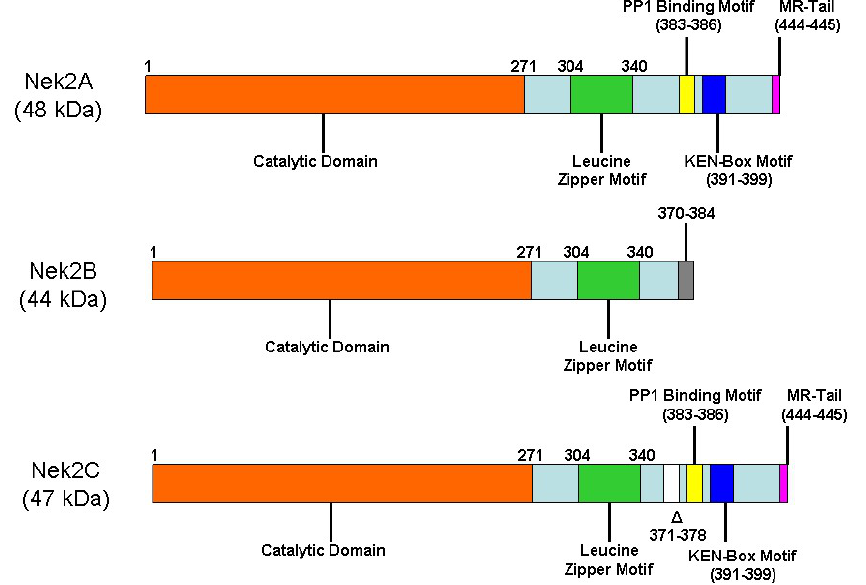
Figure 1. Structural organization of the three splice-isoforms of Nek2 kinase at the primary sequence level: Nek2A, Nek2B, and Nek2C. The three isoforms differ significantly at their C-terminus and are reported to play context-specific roles.